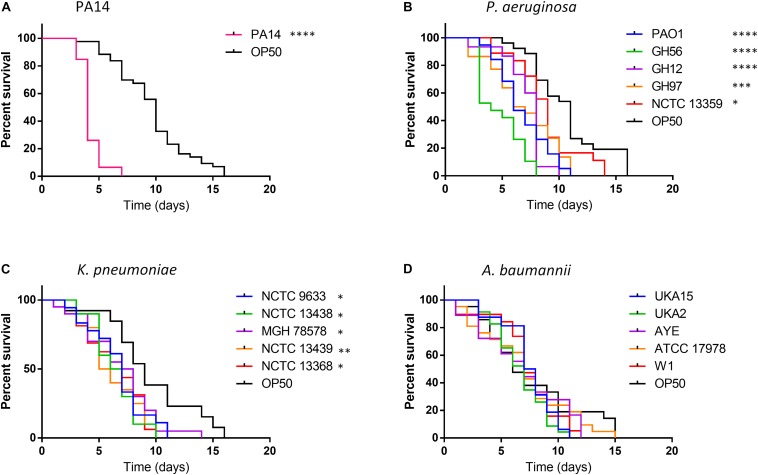
Survival of C. elegans exposed to strains of P. aeruginosa, K. pneumoniae, and A. baumannii relative to E. coli OP50. C. elegans survival after challenge with P. aeruginosa PA14 (A), other P. aeruginosa strains (B), K. pneumoniae
(C) and A. baumannii
(D) was recorded every day until 100% mortality was observed in the E. coli OP50 control. A log-rank (Mantel–Cox) test was used to compare the mortality of all strains relative to OP50 and significance is indicated. ∗P < 0.05, ∗∗P < 0.01, ∗∗∗P < 0.001, ****P < 0.0001.